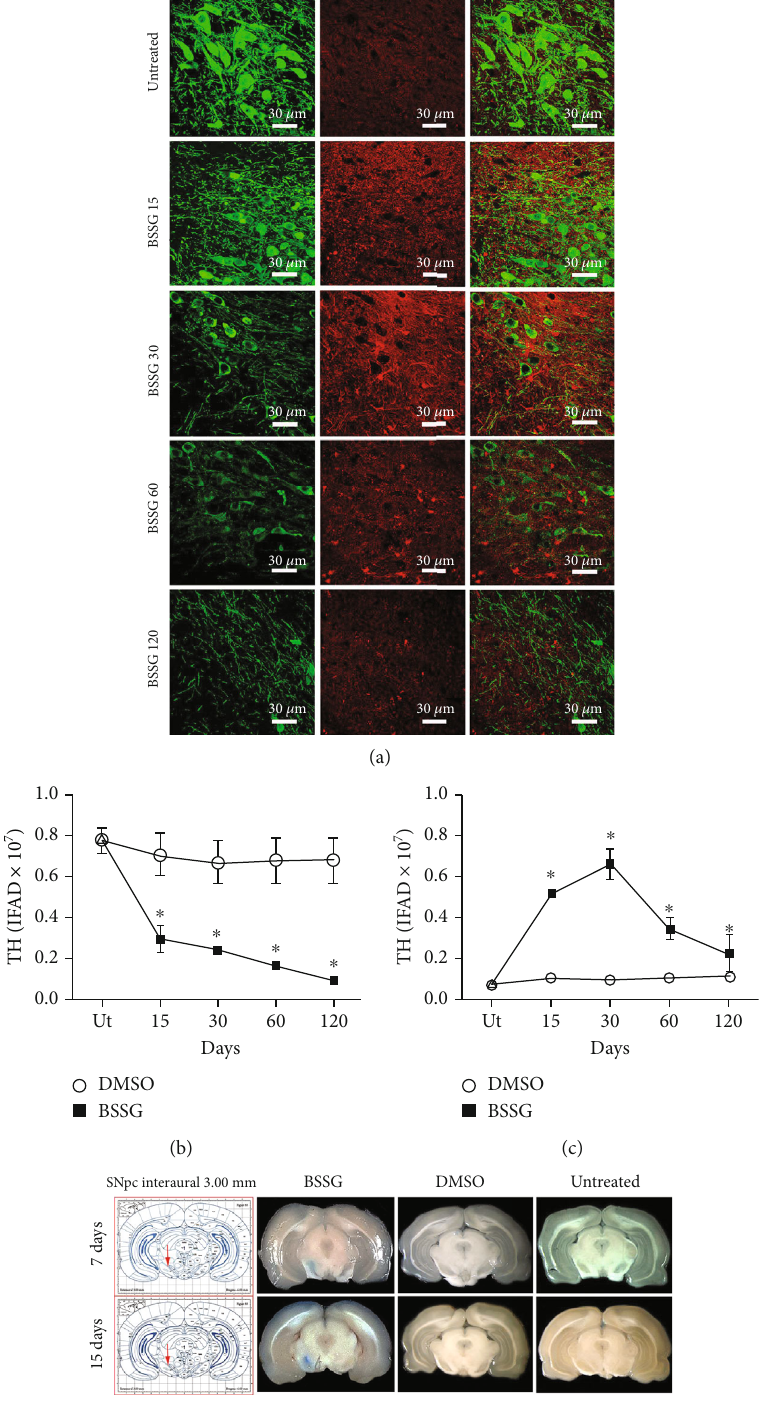
Figure 9: Time course of leukocyte in fi ltration after a BSSG injection in the SNpc. (a) Representative micrographs of double immuno fl uorescence of TH and CD45 in untreated (Ut) control rats and rats at di ff erent times (shown at the left side of micrographs) after BSSG injection. IFAD quanti fi cation for TH and CD45 during the experimental time course. The (b) TH and (c) CD45 values for the mock rats correspond to the quanti fi cation in Supplementary Figure 7. The values are the mean ± SD from four anatomical levels. n = 3 independent rats in each time of each experimental condition. Two-way ANOVA and post hoc Bonferroni tests were applied for statistical analysis. ( ∗ ) indicates a P < 0 : 05 compared with the DMSO mock and Ut groups of the respective immunostaining. (d) Representative photographs of brain slices after intravenous injection of the Evans blue dye on the days shown at the left of each